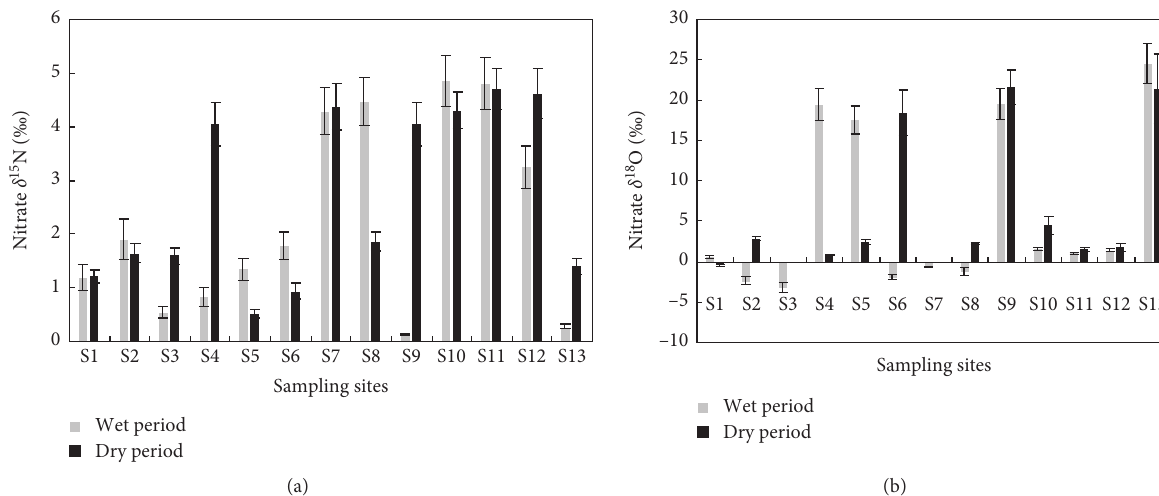
Figure 3: Distribution characteristics of nitrogen and oxygen isotope in the study area.